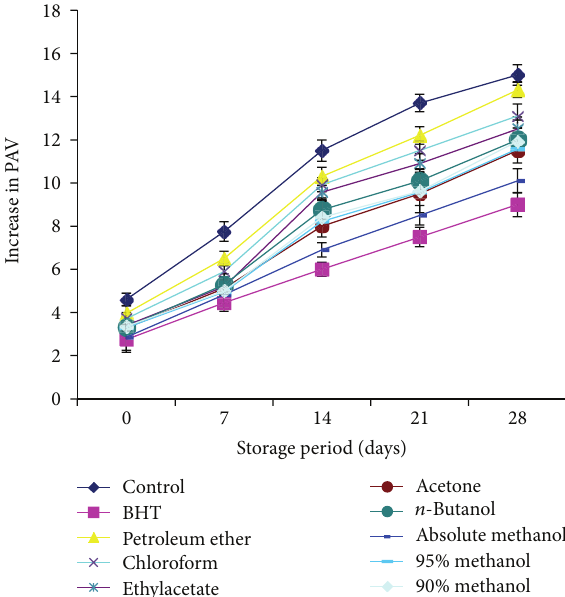
Figure2:Freefattyacidcontents(%)ofsunfloweroilstabilizedwith C. viminalis leaves extracts.